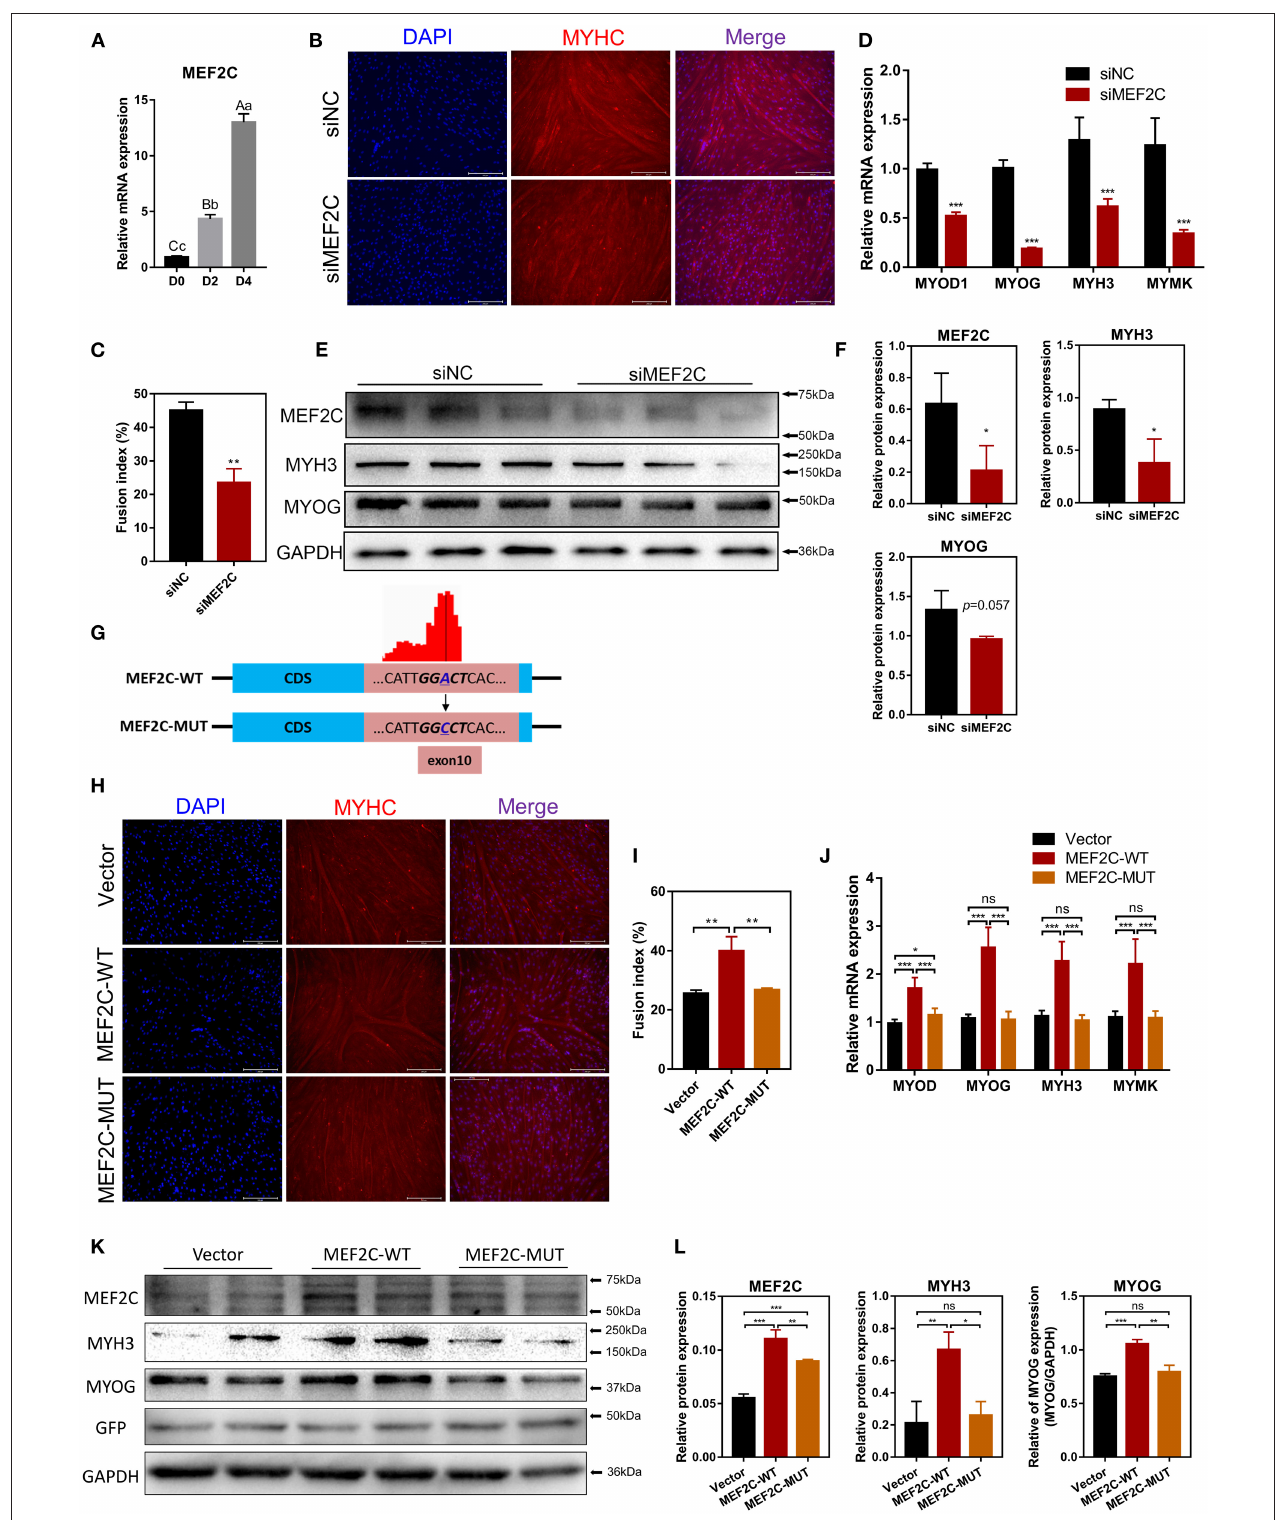
FIGURE 3 | MEF2C promotes bovine skeletal myoblast differentiation, and its expression and function in myoblast differentiation are regulated by m 6 A modification. (A) Relative mRNA expression of MEF2C during bovine skeletal myoblast differentiation. (B–F) After myoblasts were transfected with siRNA for 24h,